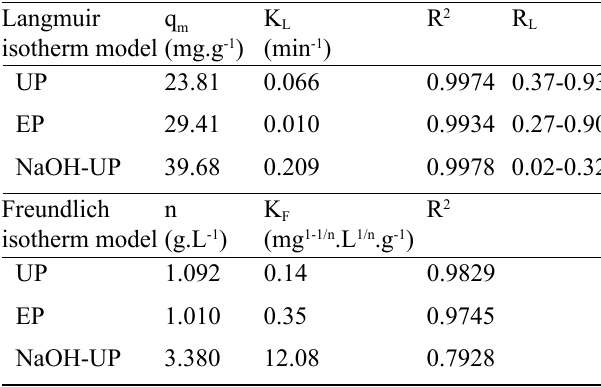
Table 4. Isotherm models and constants for adsorption of MG onto the studied adsorbents.